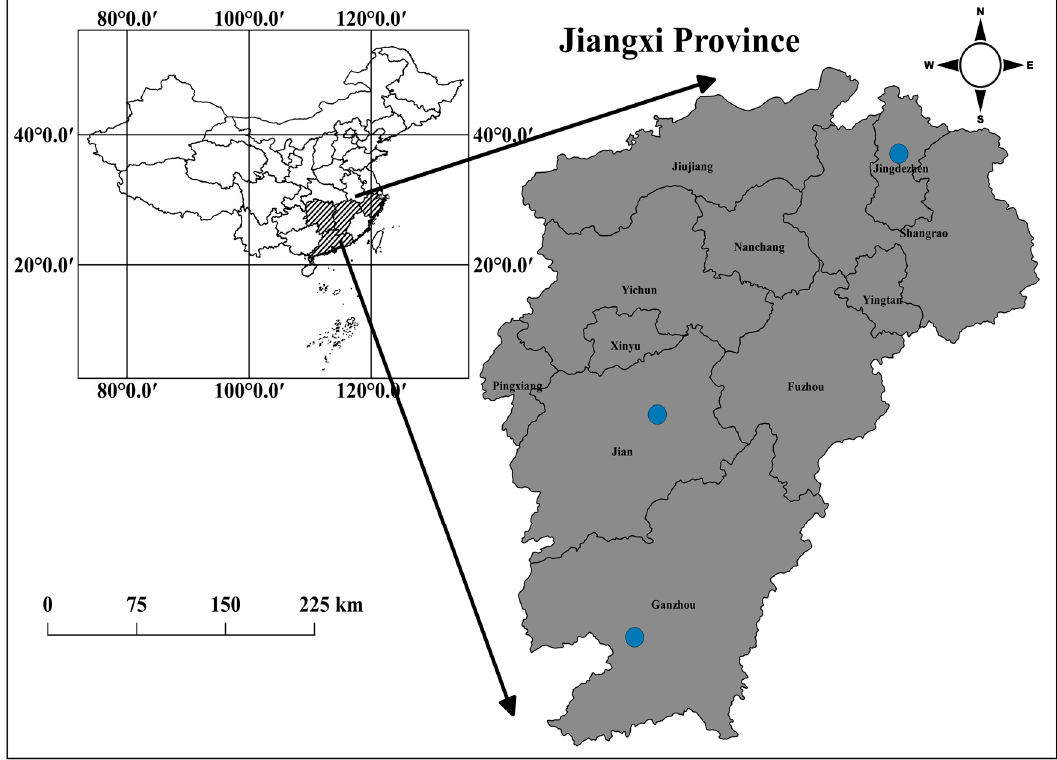
Figure 1. Location of the progeny trails (blue dots) in Jiangxi Province and main growing regions (shaded area) of P. elliottii in china.